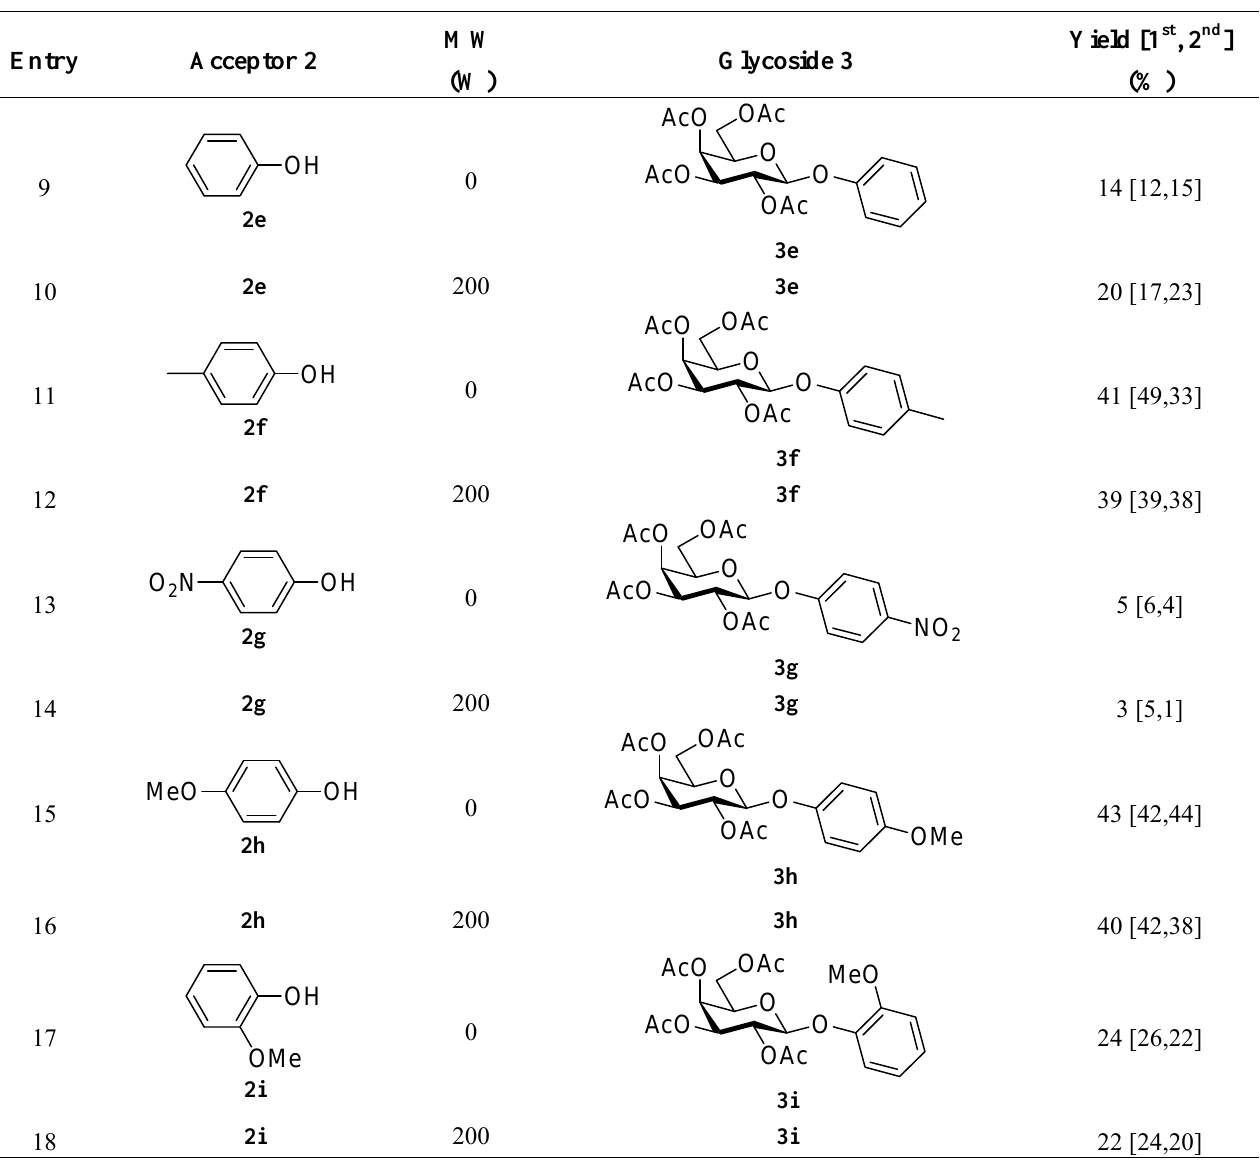
Table 2. Glycosylation of 1 and phenolic glycosyl acceptors 2e - i promoted by ZrO scCO with or without MW 2